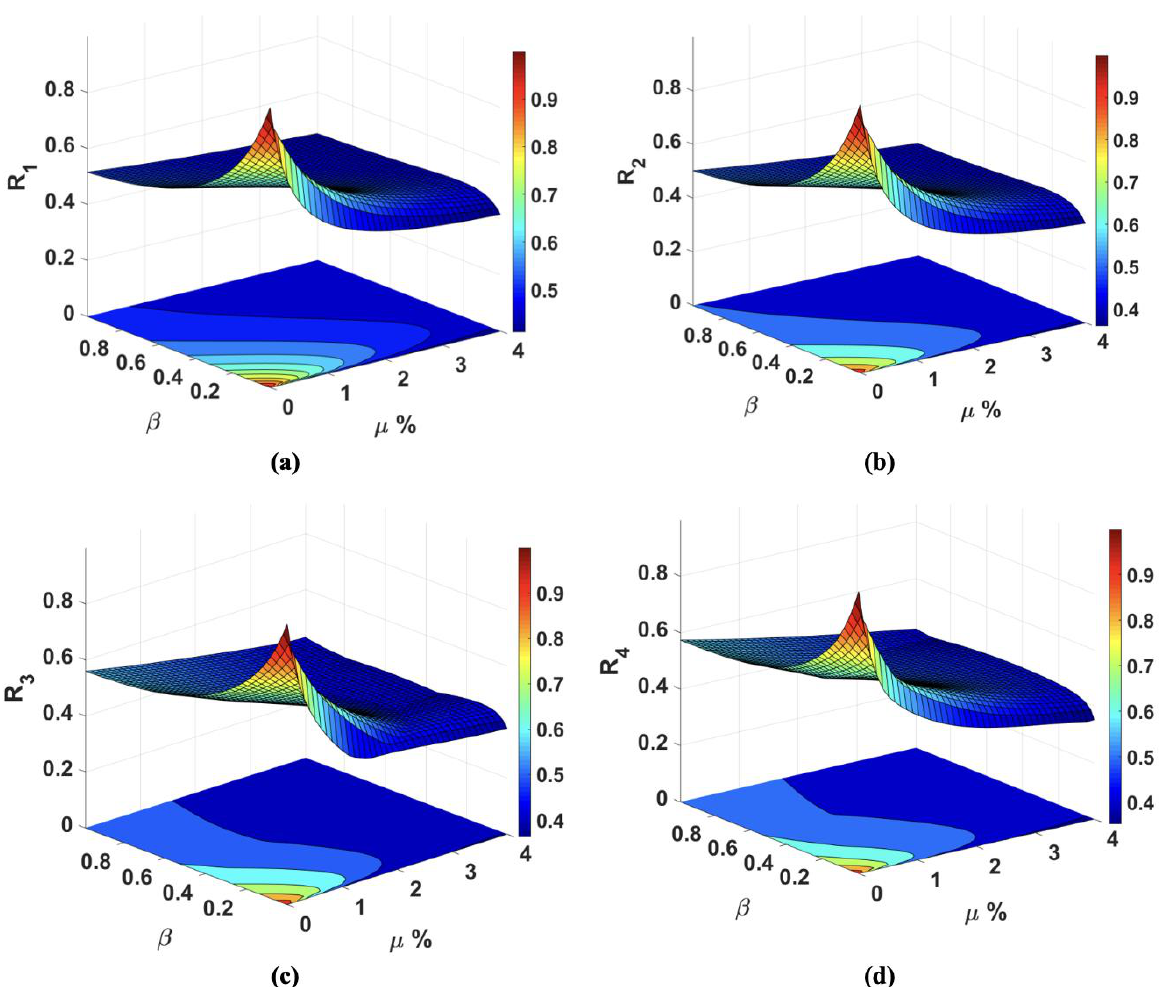
Figure 9. Effect of the inertance ratio and the mass ratio on the structural responses under filtered white-noise excitations: ( a ) RMS displacement at the top floor, ( b ) RMS acceleration at the top floor, ( c ) peak displacement at the top floor, and ( d ) peak acceleration at the top floor.